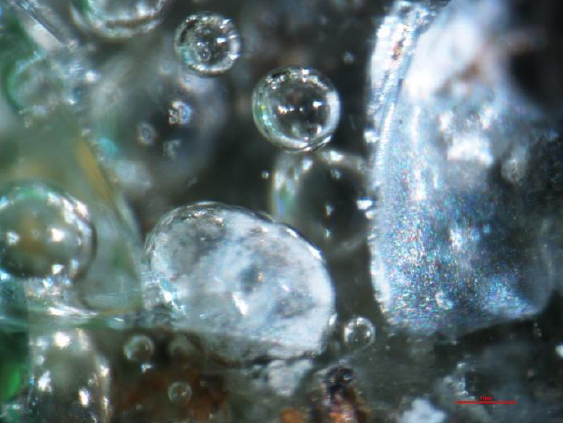
Figure 26. Pores visible under a stereomicroscope, SP1 sample, magnification 100×.